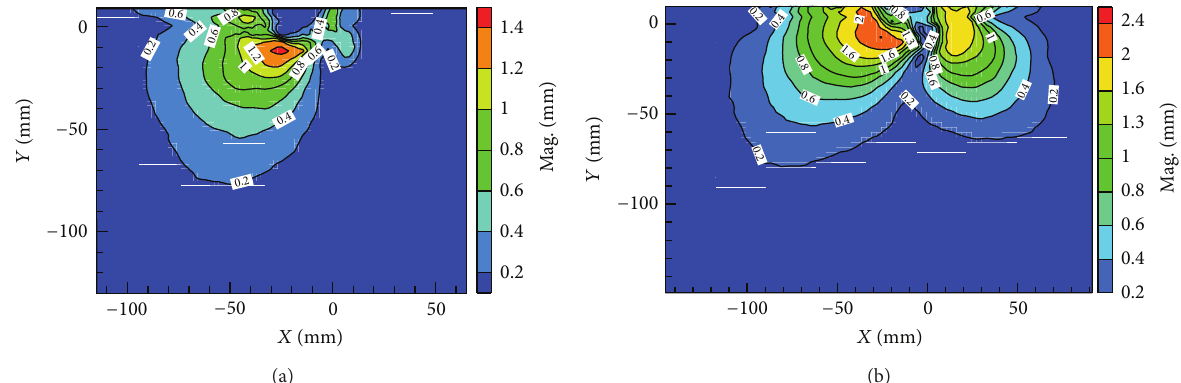
Figure8:Contoursofdisplacementfieldsatthegroundsurface:(a)contoursofdisplacementfieldindensesand;(b)contoursofdisplacement field in loose